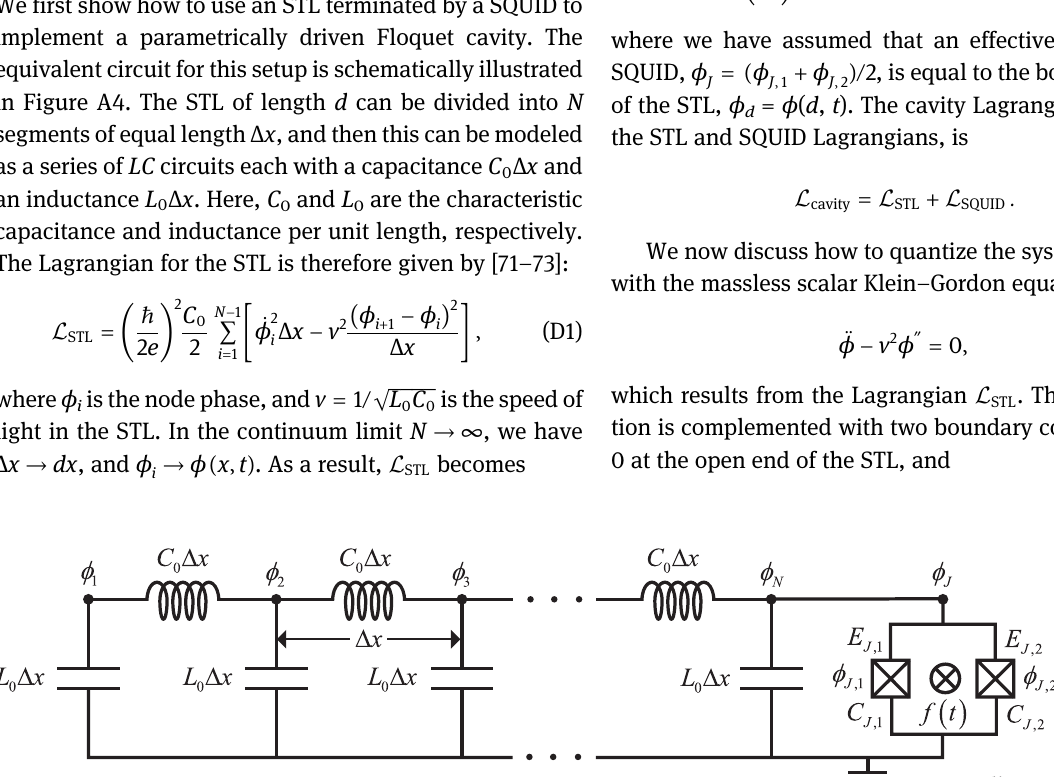
− ϕ ) / 2. The effective J , 1 J , 2 → ϕ ( x , t i